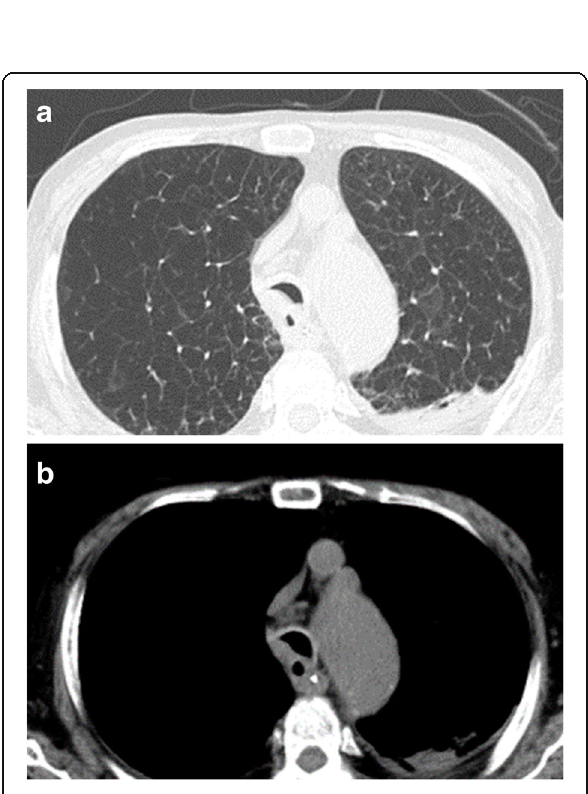
Fig. 4 Postoperative chest computed tomography (CT). a Expansion of the stenotic area on chest CT at 6 months postoperatively. b Scars covering the dorsal side of the membranous portion of the bronchial tube at 6 months